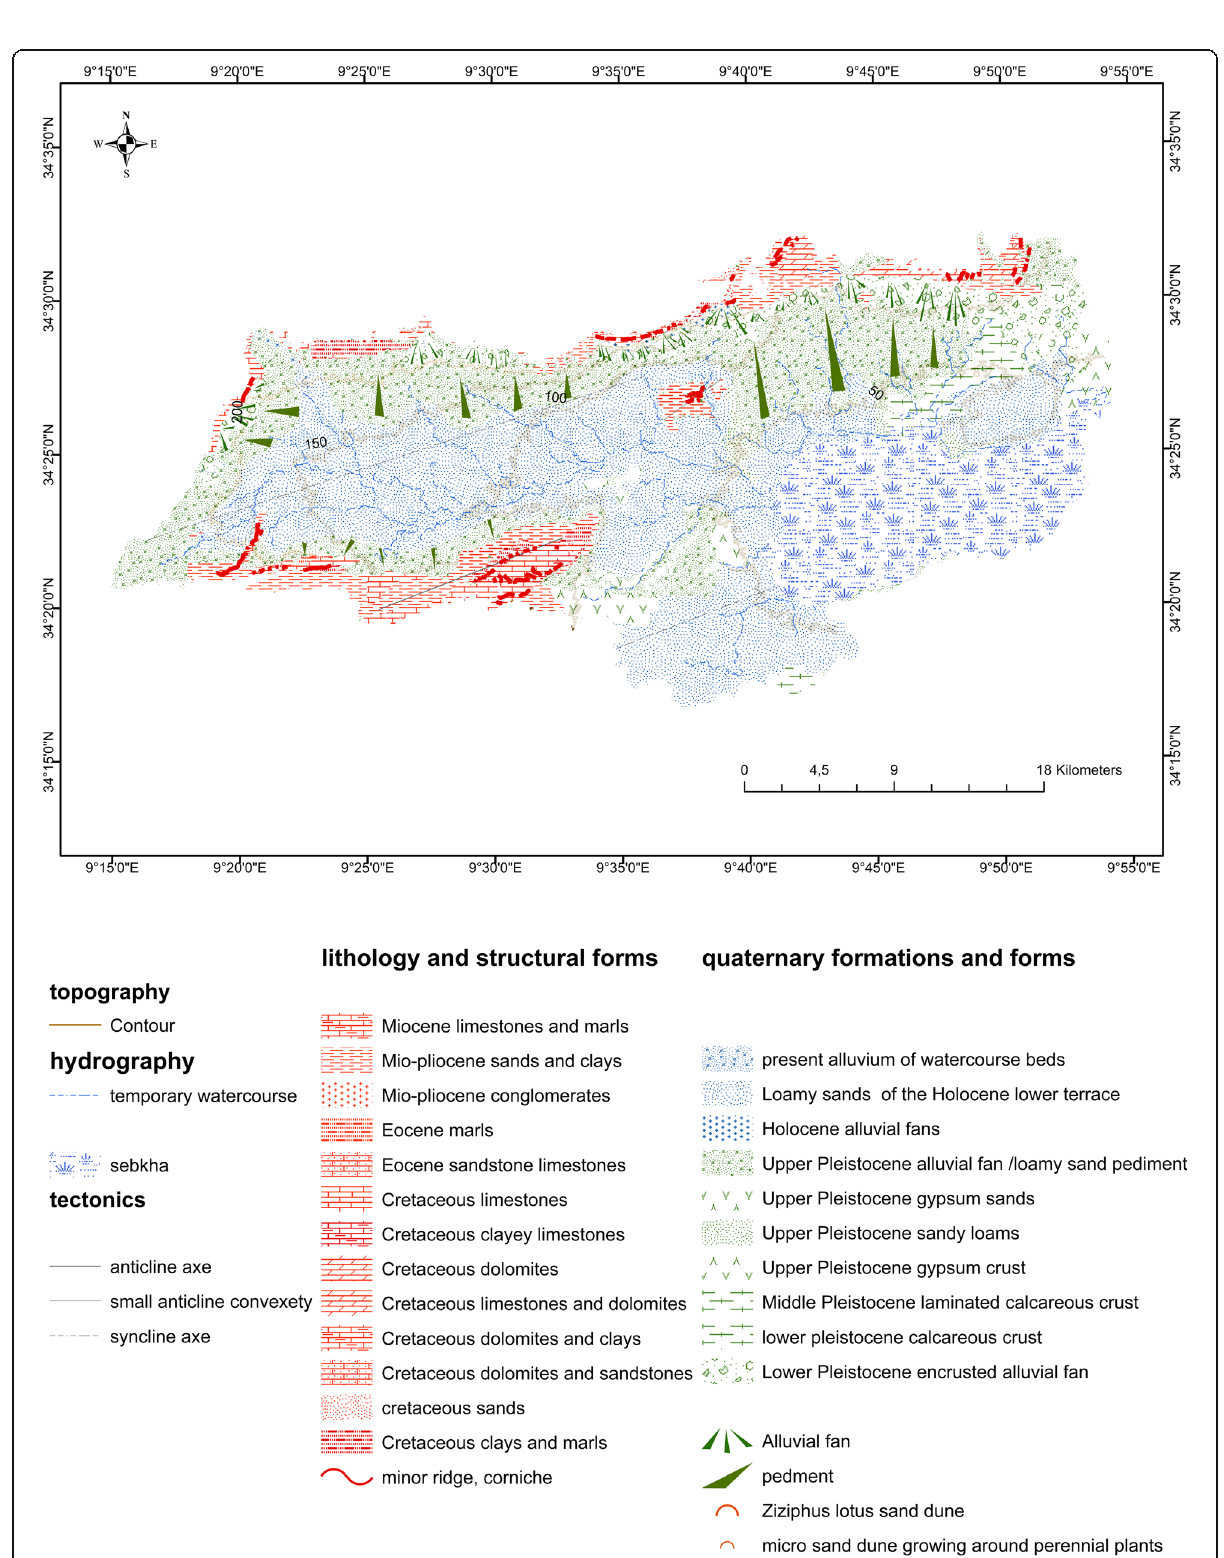
Fig. 3 Geomorphological map with legend ((Source: National office of mines, Geological map at 1/50000 sheets n° 120, 113. Geological map at 1/500000 southern part (National office of mines n.d.). Office of Topography and Cartography, Tunisia. topographical map, 1/50000 sheets n°113,120,121 (Office of Topography and Cartography n.d.). My own field knowledge (work in